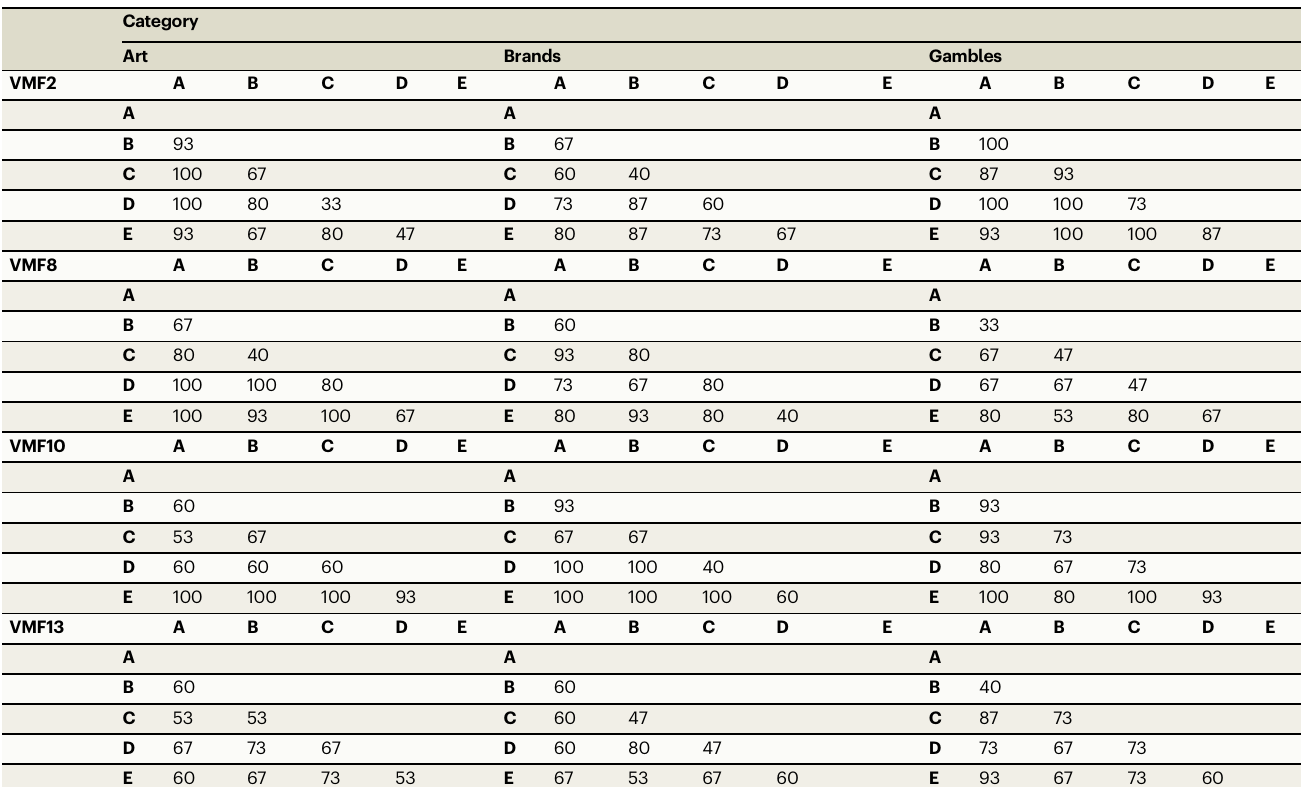
Table 2 | Choice percentages (in set A) for four individuals with VMF damage